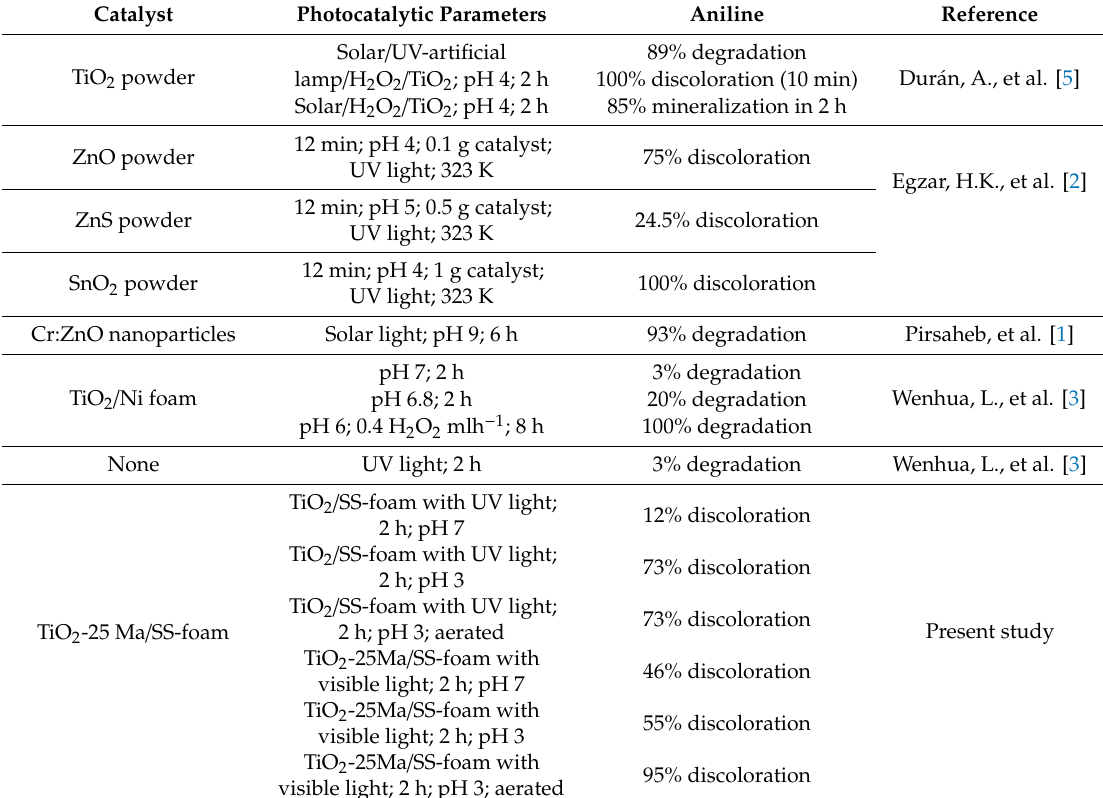
Table 3. Aniline oxidation studies on photocatalytic processes compared with the present